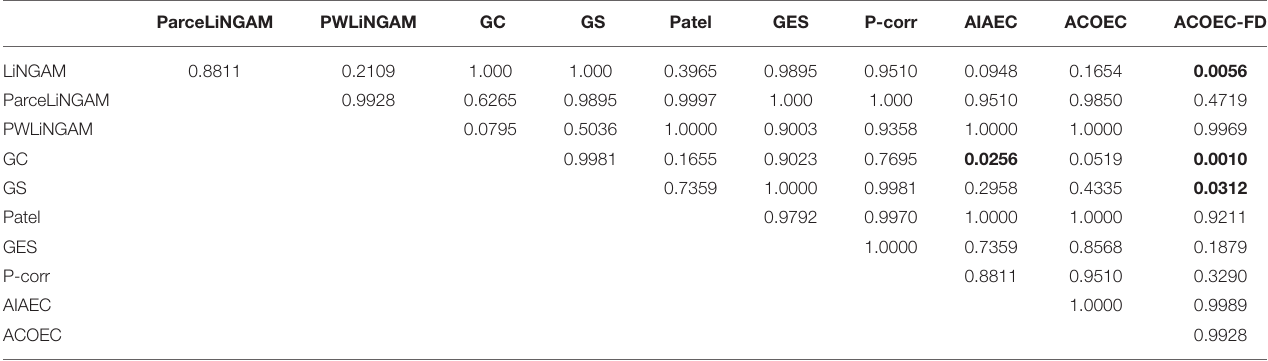
TABLE 8 | The post-hoc test results of p -values on SHD value.